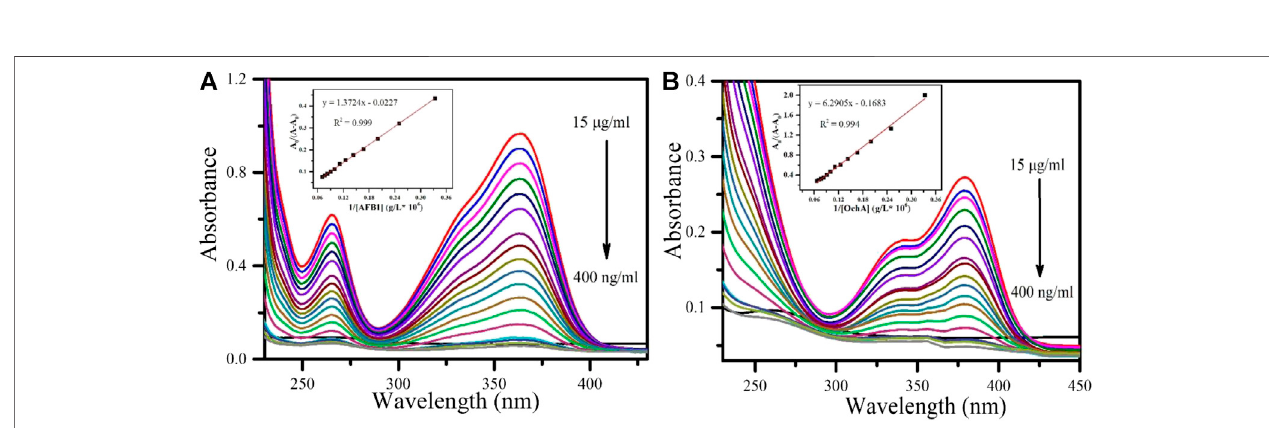
FIGURE6| UV-visibleresponsestudyof (A) AFB1atdifferentconcentrations(inset)calibrationcurveofAFB1 (B) OchAatdifferentconcentrations(inset)calibration curve of OchA.